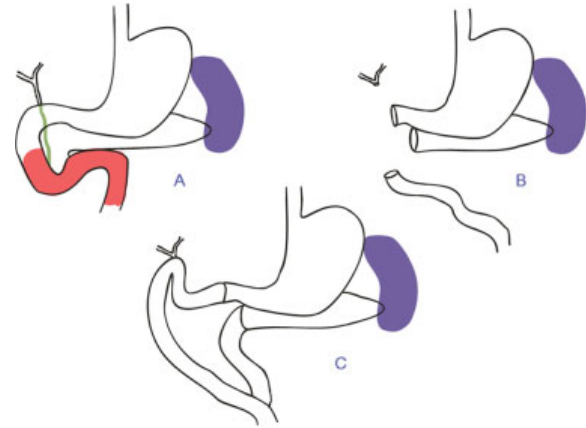
Fig. 3 Schematic diagram of pancreaticoduodenectomy: (A and B) The entire duodenum was removed along with the head of the pancreas; (C) a pylorus-preserving pancreaticoduodenectomy, with biliary and pancreatic diversion into a Roux-en-Y jejunal loop was